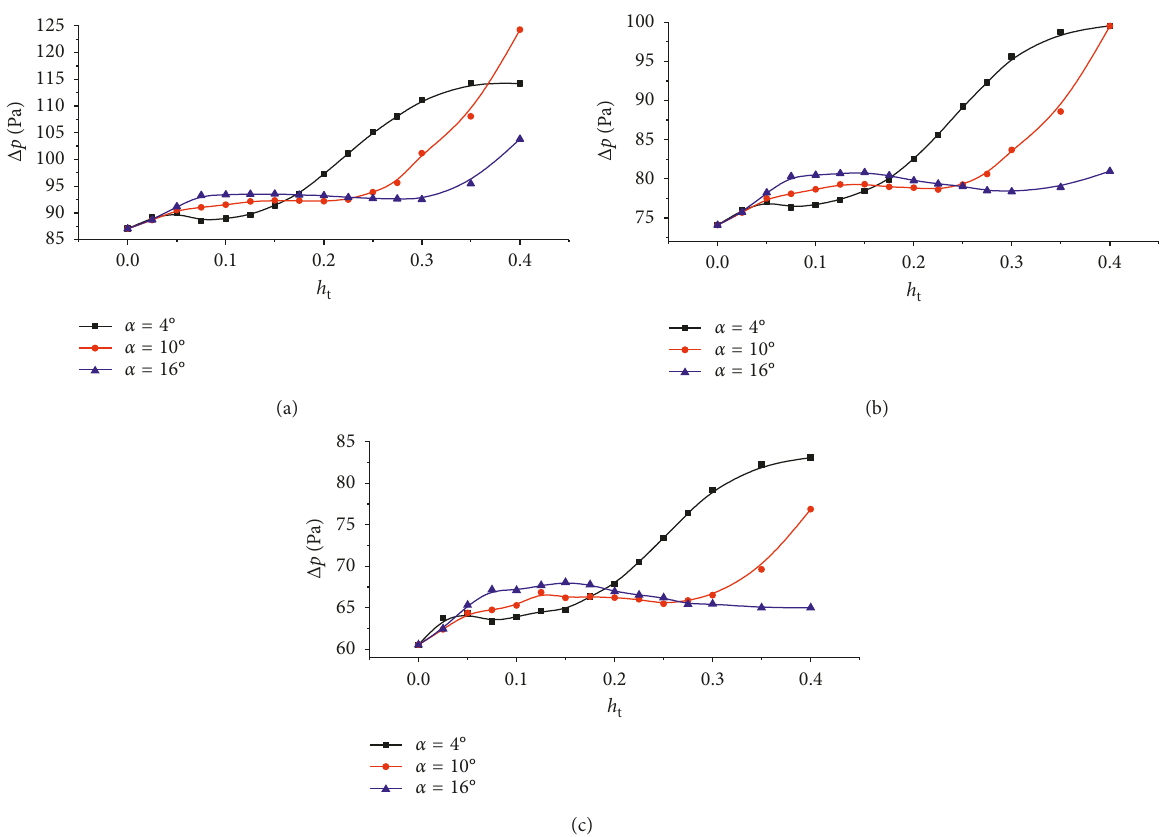
t for various α . (a)